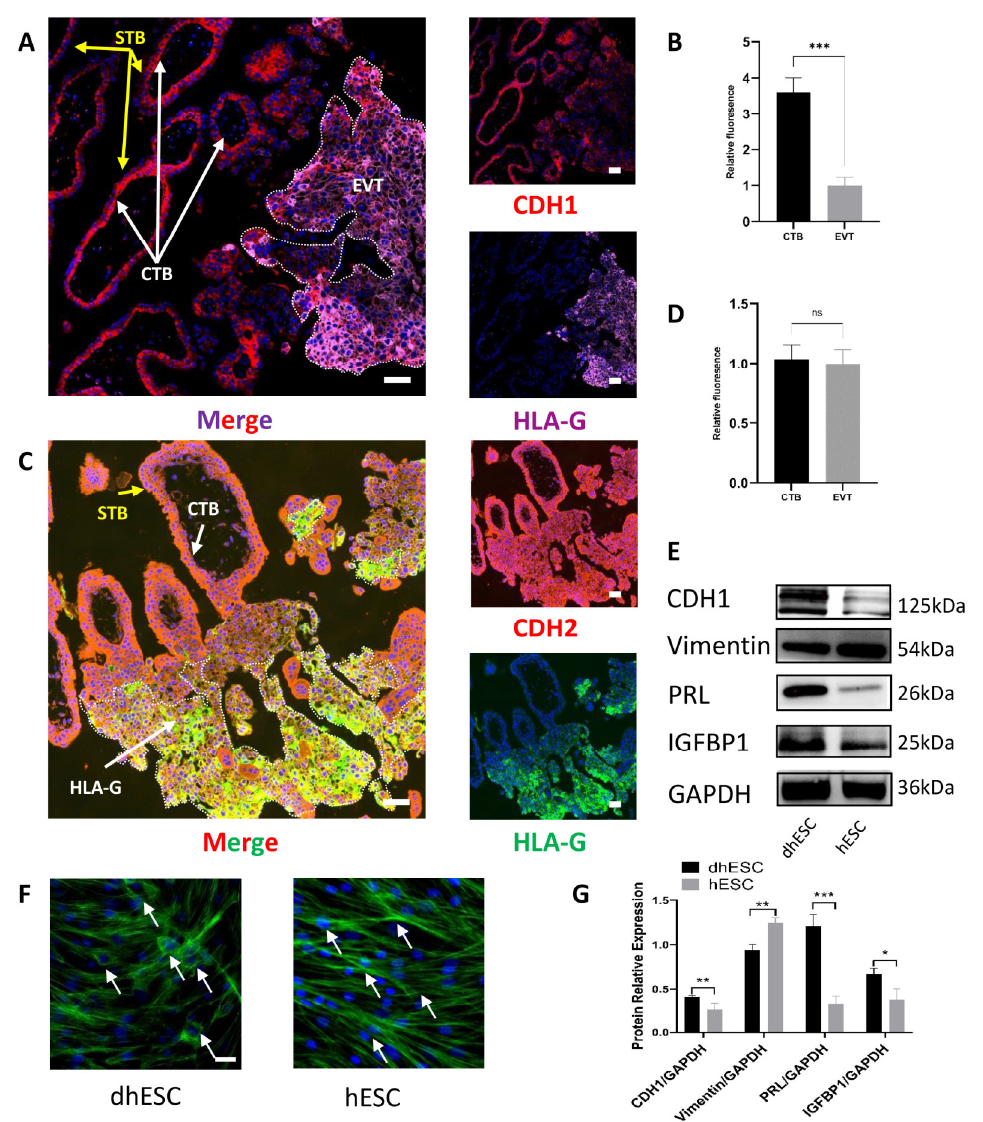
Figure 1. Partial EMT occurs in placental development, while MET occurs during decidualization. ( A , B ) CDH1 location and expression levels in CTBs and EVTs were measured by coimmunofluores- cence in early pregnancy villi ( n = 3). Scale bar = 50 nm in ( A , B ). ( C , D ) CDH2 location and expression levels in CTBs and EVTs were measured by coimmunofluorescence in early pregnancy villi ( n = 3). Scale bar = 50 nm in ( C , D ). *** p < 0.001; ns, not significant. ( E , G ) Western blot tests of MET and decidualization markers during decidualization in vitro. The experiment was repeated three times independently. dhESC: decidualized hESC. GAPDH served as a loading control. Band intensities were quantified and normalized to the GAPDH values. Values are the mean ± SD. * p < 0.05; ** p < 0.01; *** p < 0.001; ns, not significant. ( F ) F-actin staining of dhESCs and hESCs shows cytoskeletal changes during decidualization. Scale bar = 50 nm. CTB: cytotrophoblast; EVT: extravillous trophoblasts; EMT: epithelial–mesenchymal transition.